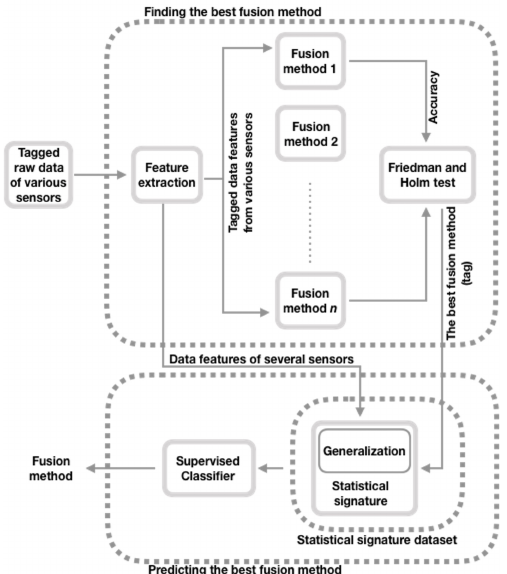
Figure 1. Overview of the extended method that predicts the optimal fusion